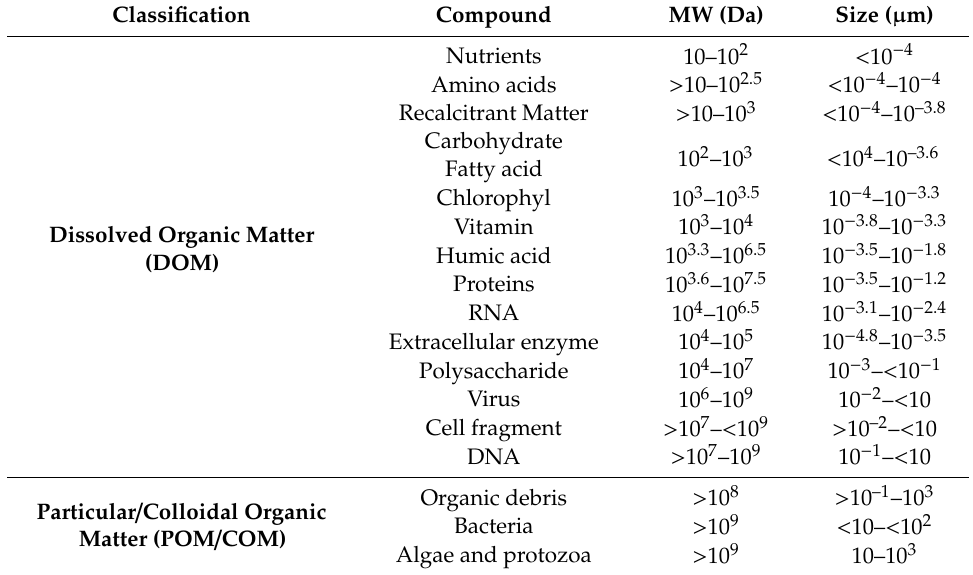
Table 2. Size ranges of typical organic components in biological treated